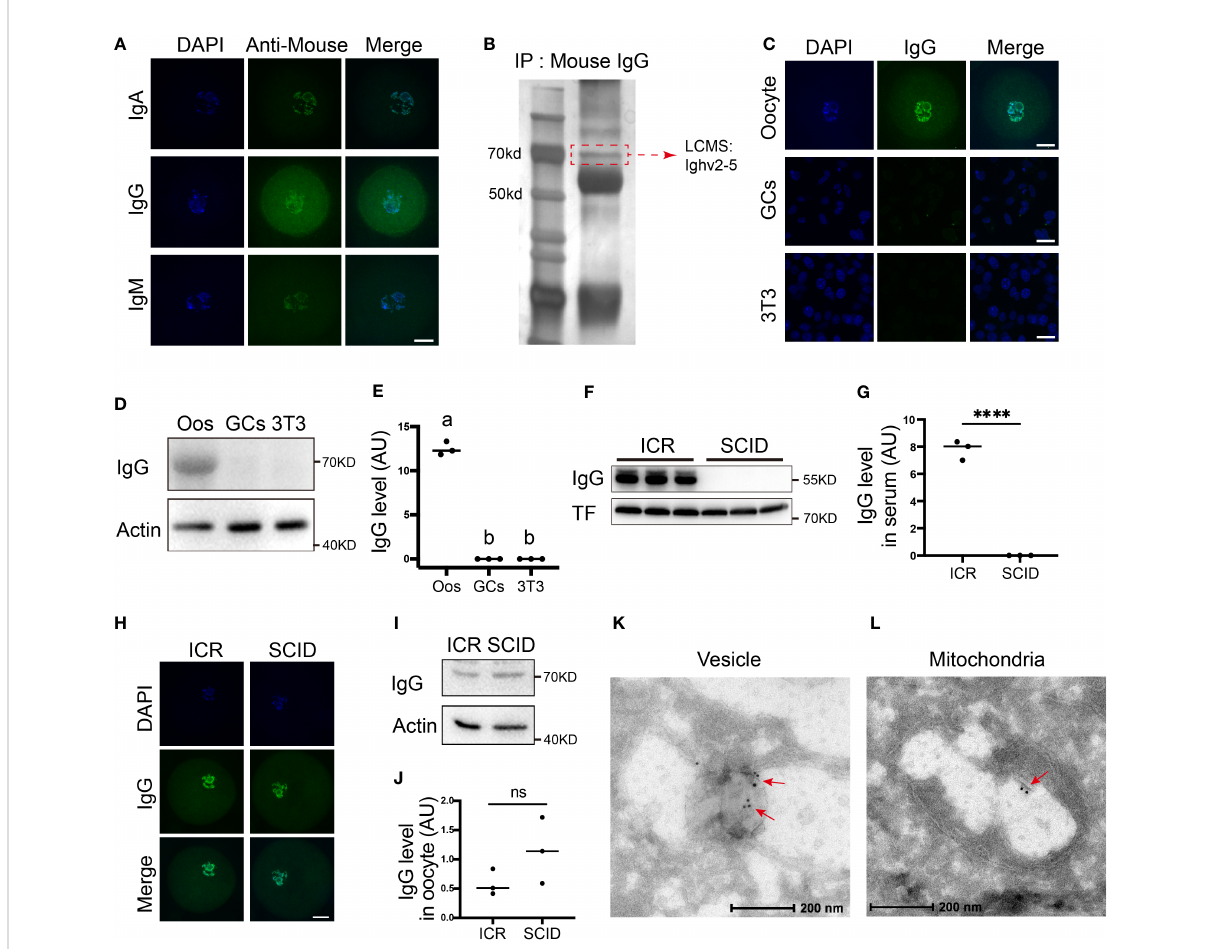
FIGURE 1 Immunoglobulins are present in oocytes (A) Immuno fl uorescence shows that different types of immunoglobulins, including immunoglobulin A (IgA), immunoglobulin G (IgG), and immunoglobulin G (IgM), are all present in mouse oocytes. (B) Immunoprecipitation with anti-mouse